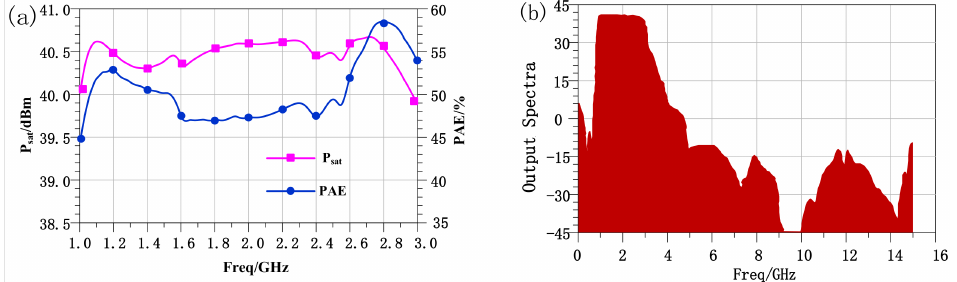
Figure 16. The measured results of frequency domain performance. ( a ) P sat & PAE performance; ( b ) Output spectra.